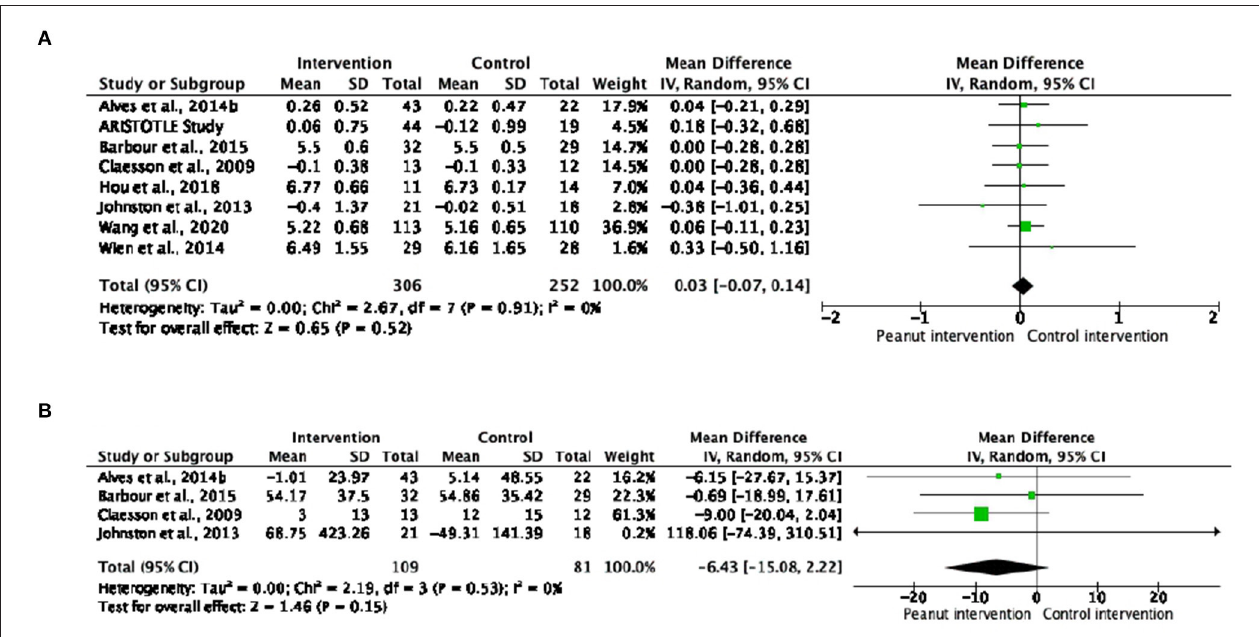
FIGURE 2 | Forest plot reporting mean differences for glucose (A) and insulin (B) associated with peanut interventions compared to control